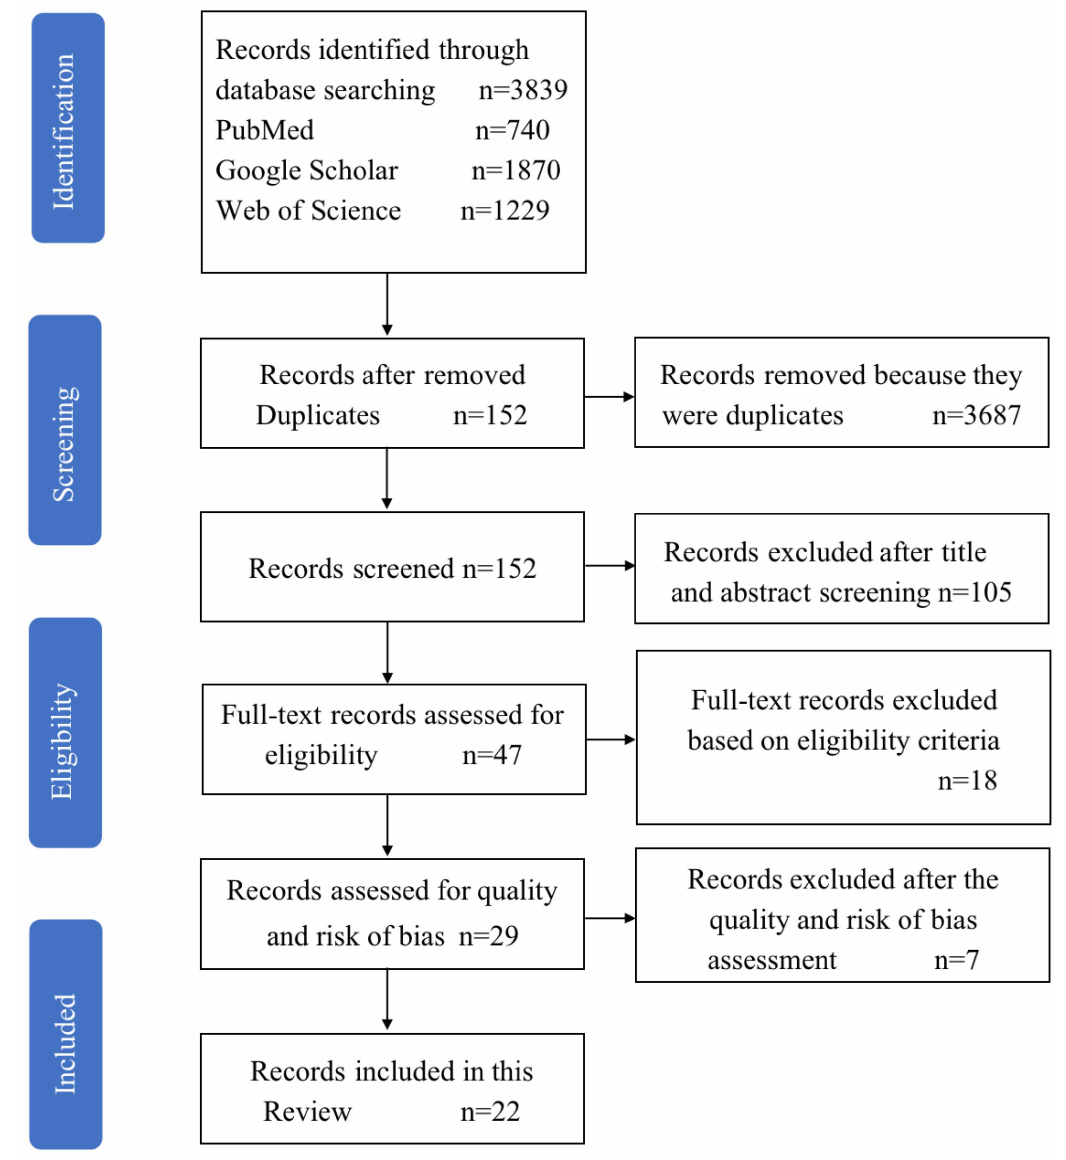
Figure 1. The flow chart of the literature inclusion in this